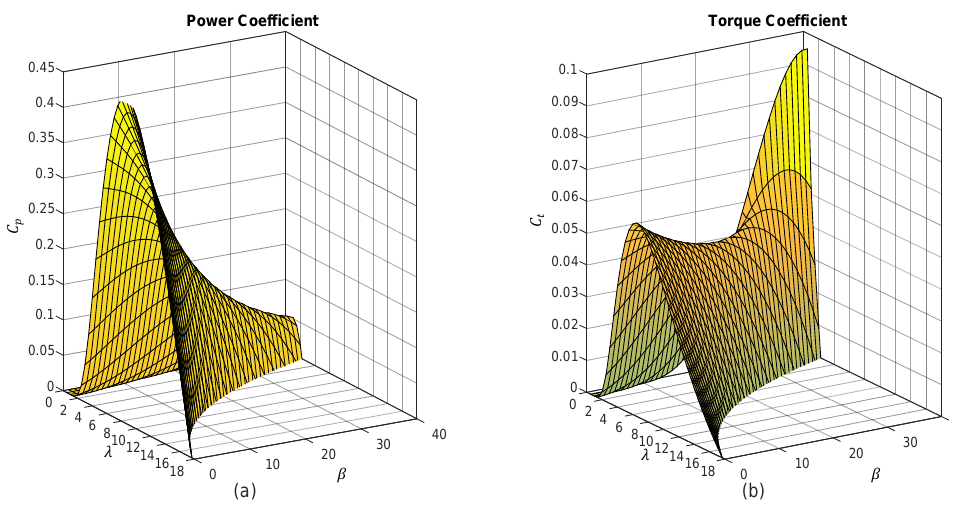
Figure 18. Coefficient proposed by Bustos, Vargas, Milla, Saez, Zareipour, and Nuñez [51], with variations of λ and β ; ( a ) power coefficient, ( b ) torque coefficient.